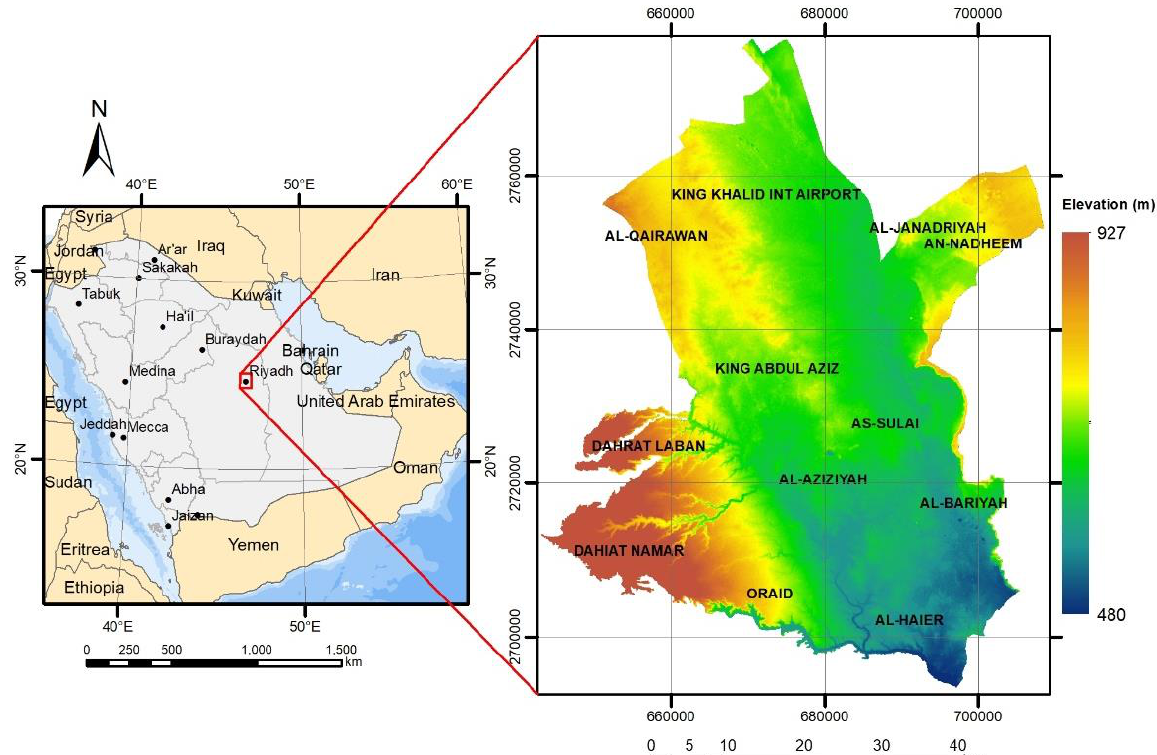
Figure 1. Location of Al-Riyadh City, Kingdom of Saudi Arabia.